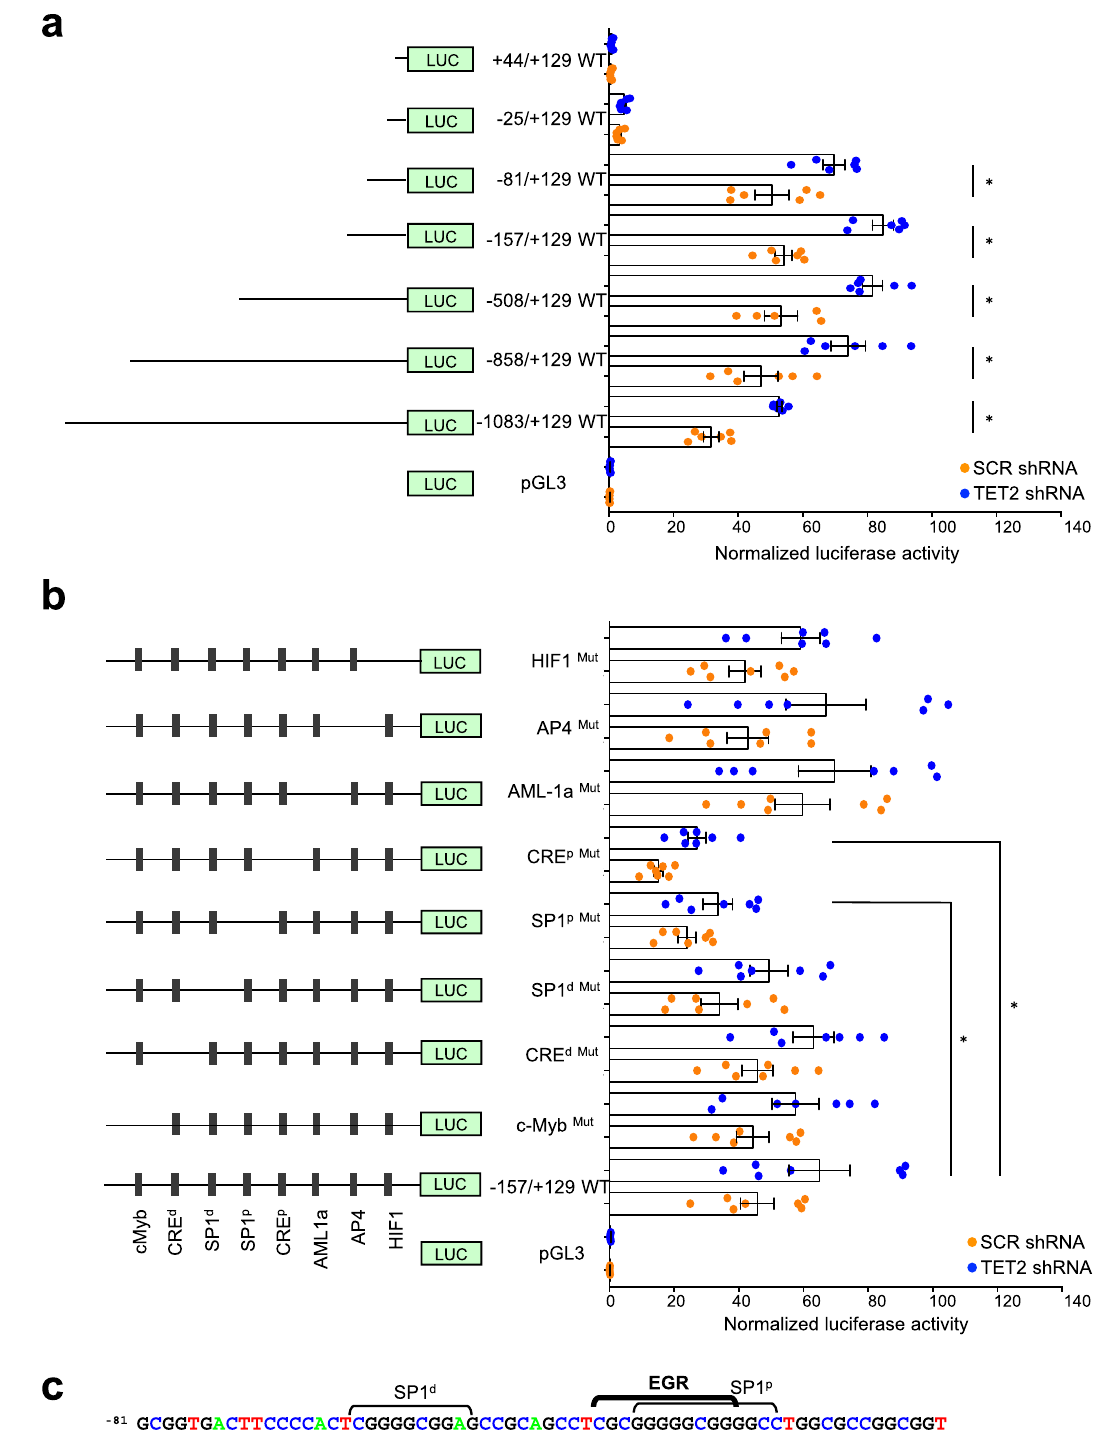
Fig. 4 Identi fi cation of a minimal proximal promoter of MIF gene. a Kasumi-1 cells stably transduced with SCR and TET2 shRNAs were transiently transfected with the pGL3 vector encoding the Luciferase gene alone (LUC) or LUC gene under control of indicated MIF promoter fragments. Cells were co- transfected with a Renilla luciferase construct for normalization and results are the ratio between luciferase and Renilla activities. Data are mean + / − SEM from at least six independent well experiments; Unpaired Students-t test, * P < 0.05. b The same experiments were performed using the − 157/ + 129 MIF promoter sequence in which mutations were induced in the DNA binding sites c-Myb, CRE d , CRE p , SP1 d , SP1 p , AML1a, AP4, and HIF1. Data are mean + / − SEM from seven independent well experiments; Unpaired t test, * P < 0.05. c DNA consensus sequences for SP1 d , SP1 p , and EGR transcription factors in MIF proximal